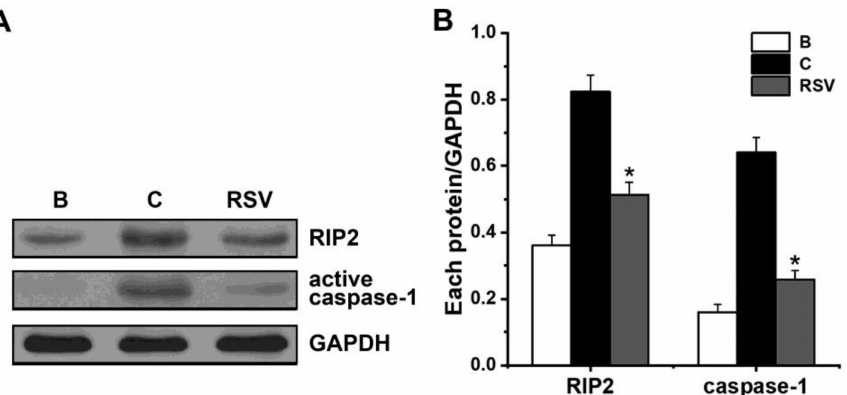
Figure 4. Effects of RSV on the activation of RIP2 and caspase-1. ( A ) Each protein was analyzed with Western blot analysis. Representative immunoblots are shown. ( B ) Each band was quantitated by densitometry. B, PBS-added group; C, PBS plus PMACI-added group. * indicates p < 0.05 versus the control (PBS plus PMACI) group.